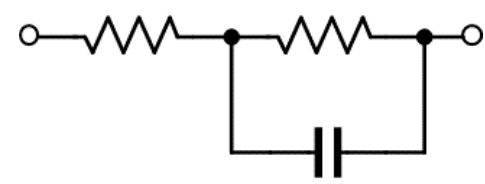
Figure 4. Schematic of an equivalent circuit of the diode.